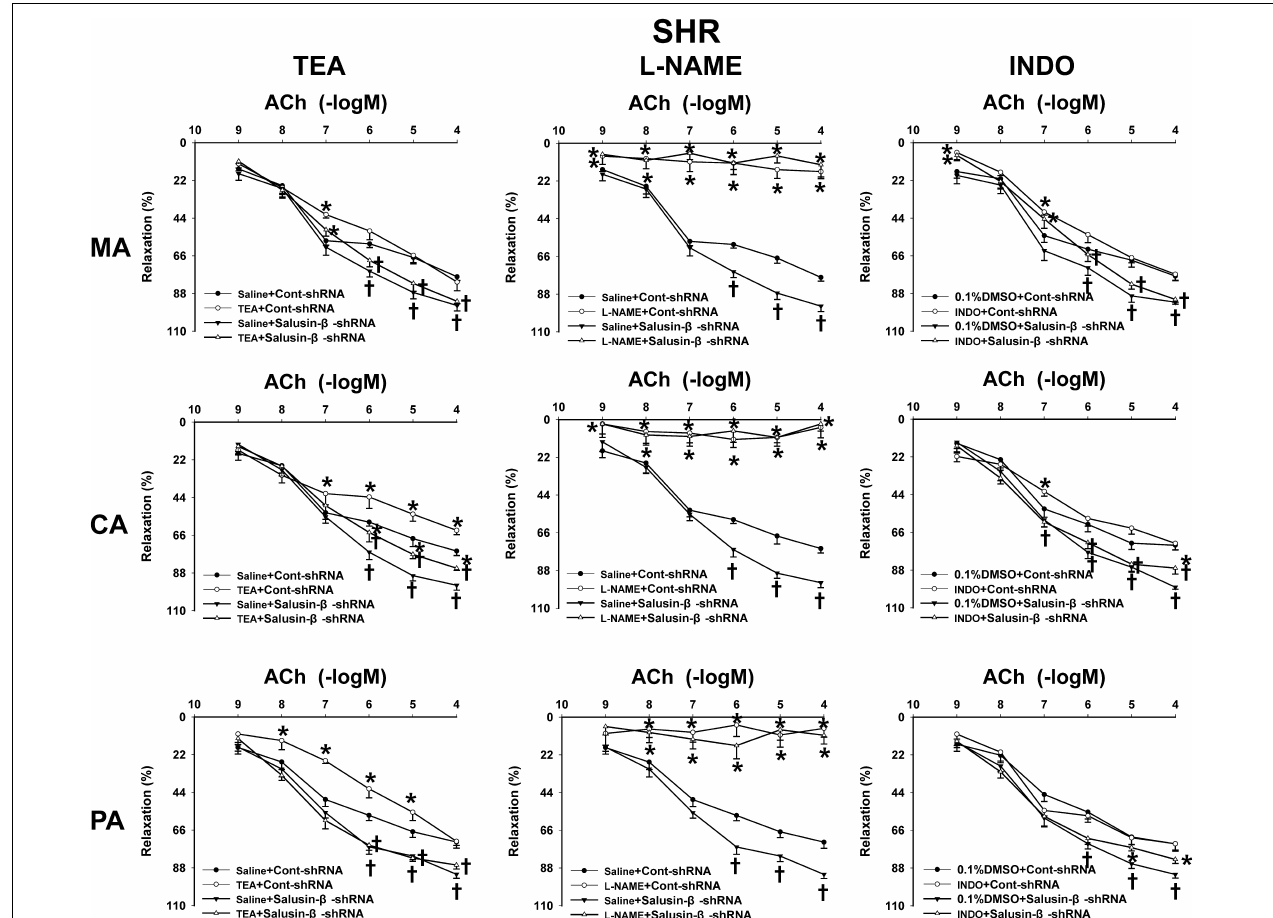
FIGURE 5 | The effects of L-NAME, INDO, and TEA on the ACh-induced vascular relaxation in SHR treated with Cont-shRNA or salusin- β -shRNA. One-way ANOVA was used for data analysis, followed by Bonferrioni post hoc test to compare with the multiple groups. Values are mean ± SE. ∗ P < 0.05 compared with Saline or 0.1% DMSO, † P < 0.05 compared with Cont-shRNA. n = 6 for each